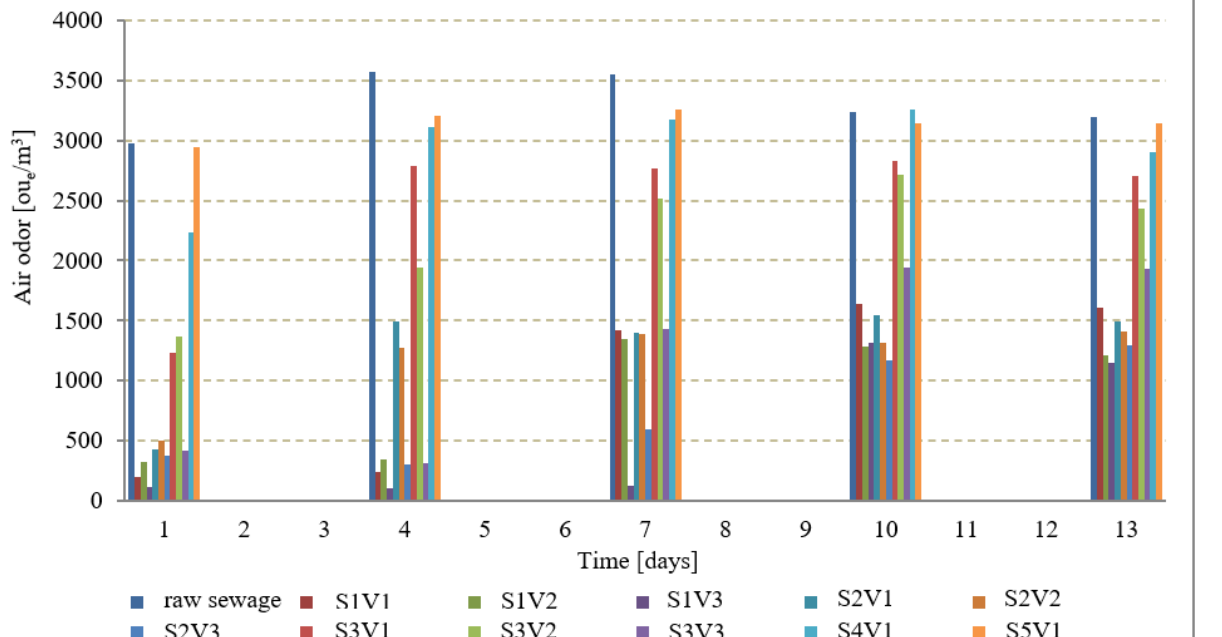
Figure 7. Odor removal across variants.